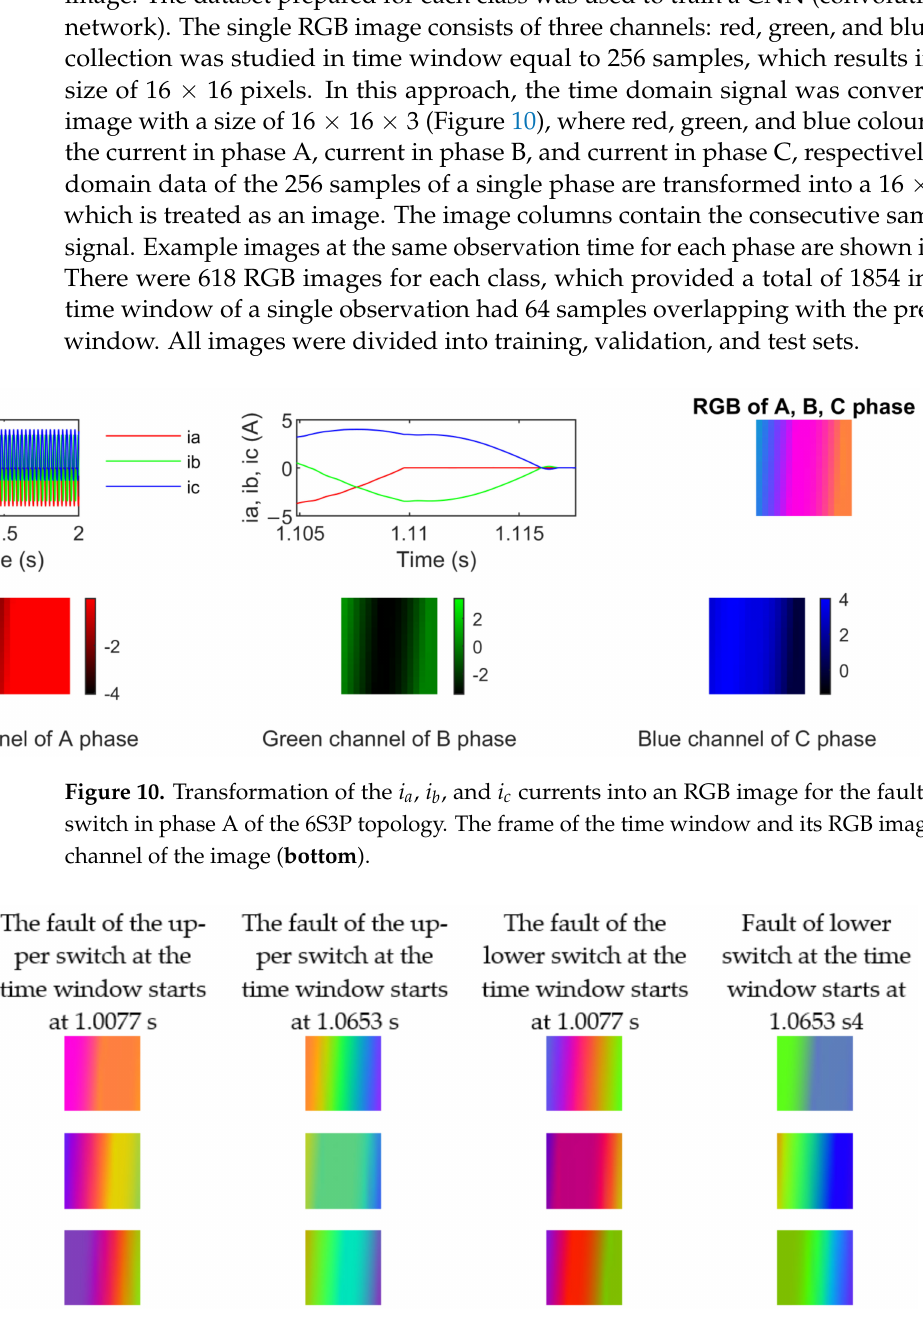
Figure 11. Example images in fault phases A, B, or C for the upper and lower switches of the 6S3P